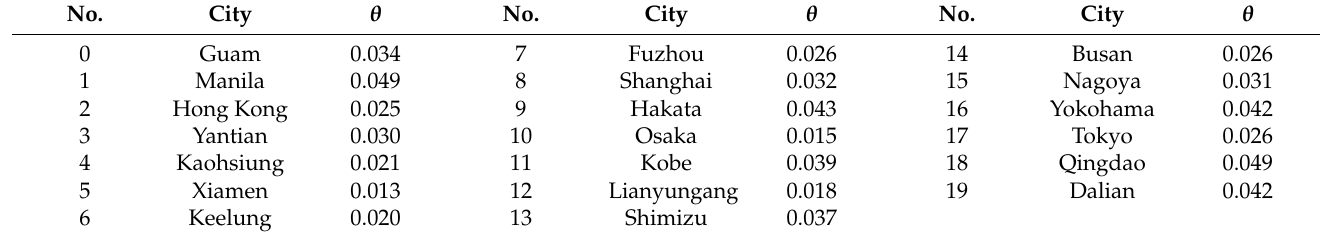
Table 2. Failure probability of each port in the RLSHLP.